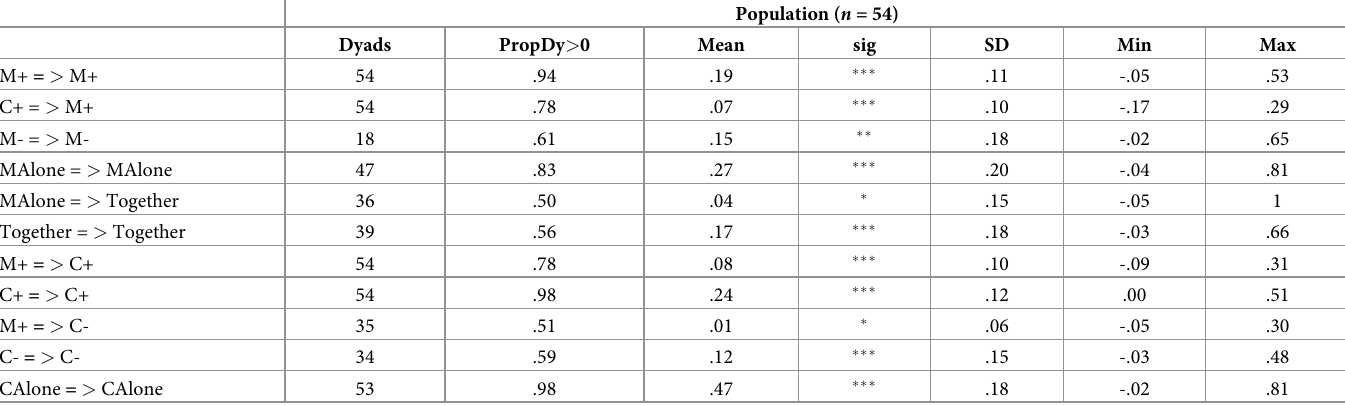
Table 4. Sequences of mother and child behaviors. Number of dyads showing the sequence (Dyads), proportion (PropDy > 0) of families showing the sequence more than would be expected by chance, mean and significance level (sig), standard deviation (SD) and range (Min, Max) for the main sample.